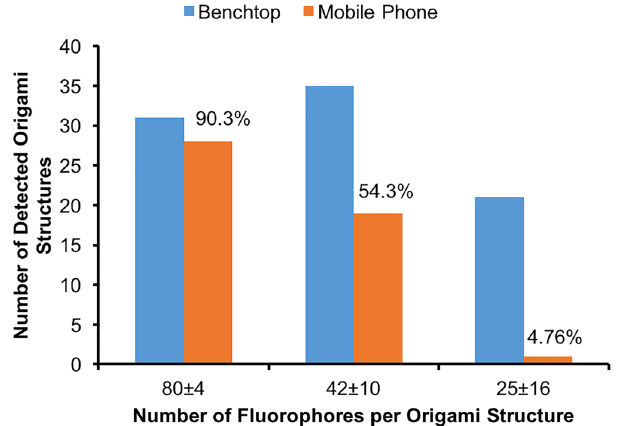
Figure 7. Detection efficiency of different DNA origami nanobeads labeled with 80 ± 4, 42 ± 10, and 25 ± 16 fluorophores by the smartphone SEF microscope. The detection efficiency was calculated by dividing the number of detected origami nanobeads using the mobile phone SEF microscope by the total number that is detected with a benchtop microscope over the same region of